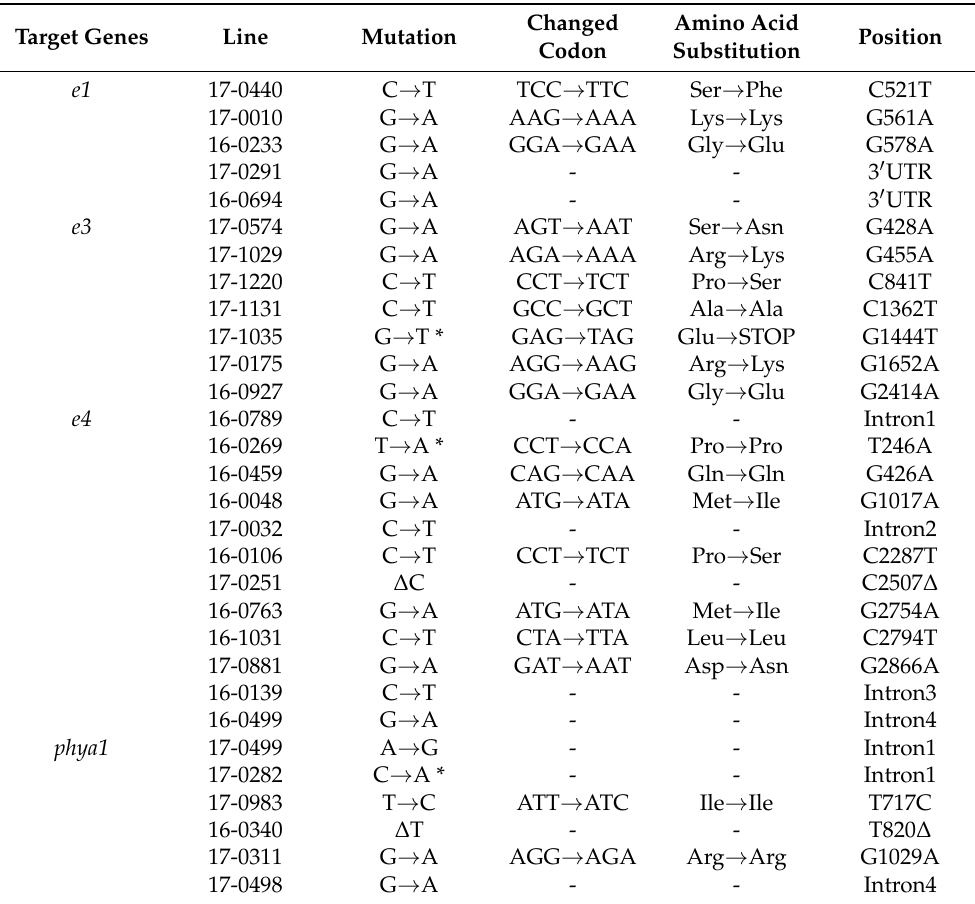
Table 2. EMS-induced base substitutions and one-base deletions in the E1 , E3 , E4 , and PhyA1 genes isolated using the TILLING method from the edamame Hiden mutant populations. ∆ in- dicates a one-base deletion. Asterisks indicate transversion mutations and no asterisks indicate transition